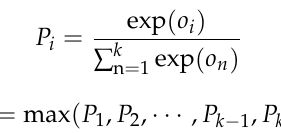
Figure 3. Example of two typical pooling operations that filter size is 2 × 2 and stride is 2. After convolution, activation, and pooling operation, the final feature map was delivered to the fully connected layer. As the name implies, every node in the previous layer is connected to every node in the next layer. First, the 3-dimensional feature map is flattened to a 1-dimensional (1D) feature vector. Except for the first conversion process, the other operations were the same as those of the multilayer perceptron. The last fully connected layer had as many nodes as the number of classes for classification. Deep neural networks used for classification tasks generally have a softmax output layer. This layer used the softmax function defined in Equation (5). o i denotes i -th node’s output value in the final fully connected layer. The output P i is the normalized probability value for i -th class. As shown in the equation, each output value passes through an exponential function. Then, each scaled value is divided by the sum of all outputs. A neural network selects the output class that has the greatest possibility, as shown in Equation (6).